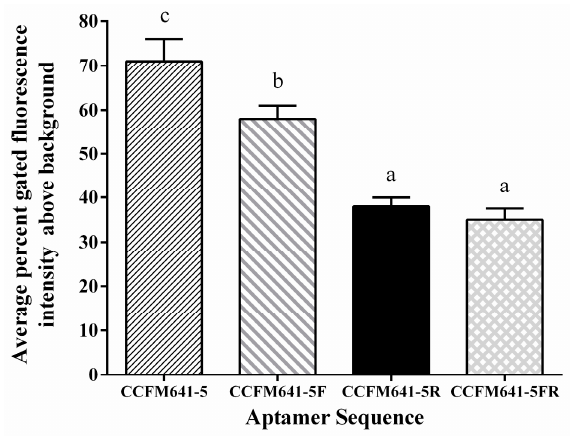
Figure 4. Binding abilities of the truncated aptamer variants to B. bifidum compared to the full-length aptamer CCFM641-5. The values of aptamer binding represent the mean ± SD of three independent experiments. Bars with different letters are significantly different ( p < 0.05).